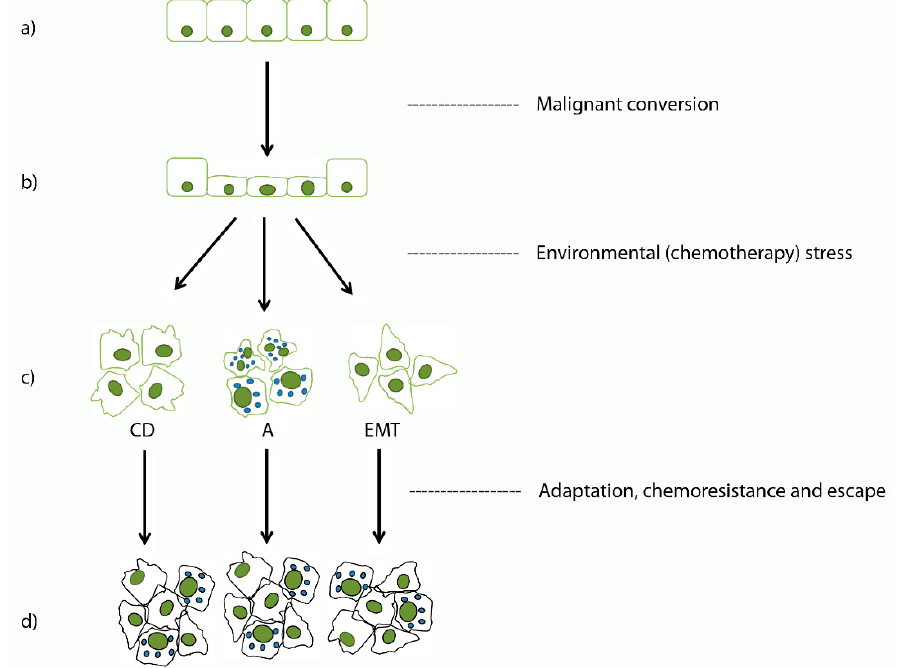
Figure 2. Selected phenotype malignant colorectal carcinoma cells develop to escape chemotherapy-dependent effects. Normal colonic epithelial cells ( a ) undergo malignant conversion ( b ) and upon exposure to various stresses (environment and/or chemotherapy-related) they became resistant to cell death (CD) or upregulate autophagy (A) or undergo epithelial-mesenchymal transition (EMT) to escape ( c ). The resulting surviving malignant cell populations are a heterogeneous mixture of cells with the mentioned phenotypes ( d